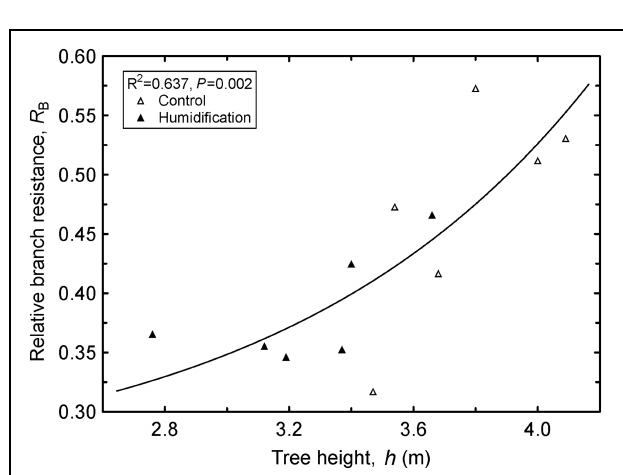
FIGURE 4 | Increase in relative branch hydraulic resistance ( R B ) with increasing tree height ( h ). Regression equation: y = 0 . 276 · e 5 . 32 · 10 − 3 x 3 . 46 .